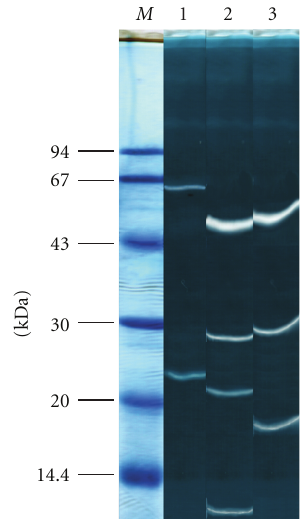
Figure 2: Gelatinous zymograms of exoproteinases obtained by SDS-PAGE of partially purified culture media after 12 days of growth of R. solani (lane 1), P. infestans (lane 2), and F. culmorum (lane 3). Lane M represents the molecular mass (kDa) markers as follows: phosphorylase b (94), bovine serum albumin (67), egg albumin (43), carboanhydrase (30), Kunitz soybean trypsin inhibitor (20,1), and lactalbumin (14.4). About 50 mcg of the protein were added onto the lines 1–3.